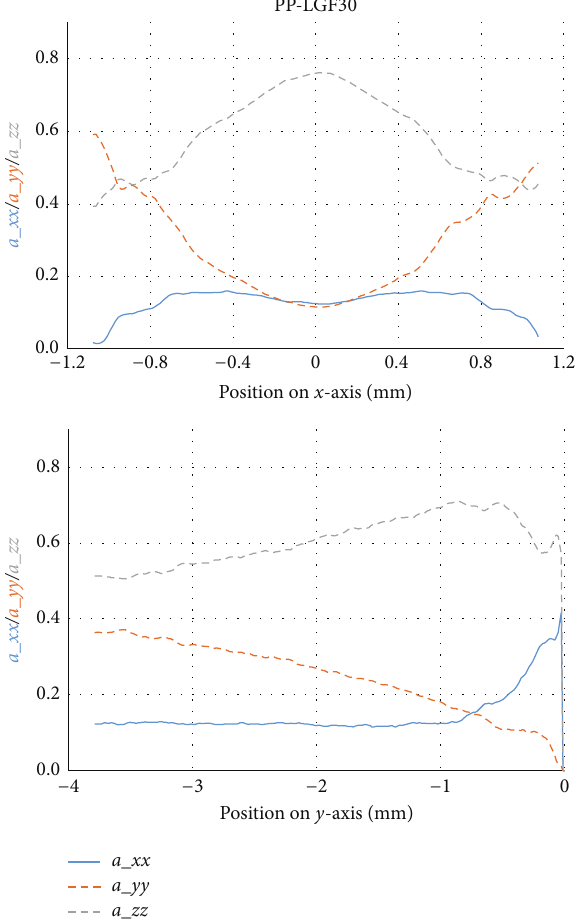
Figure 5: Progress of the fiber orientation along the 𝑥 - and 𝑦 -axis in an injection molded plate of PP-LGF30.